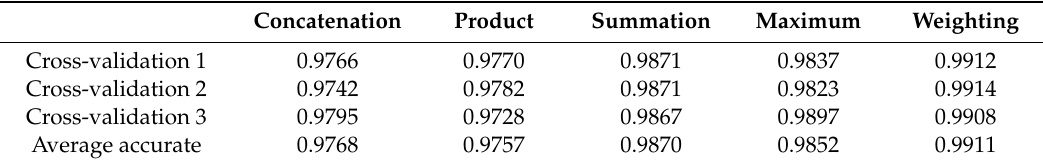
Table 5. The accuracy comparison using various fusion methods in a MORPH dataset.